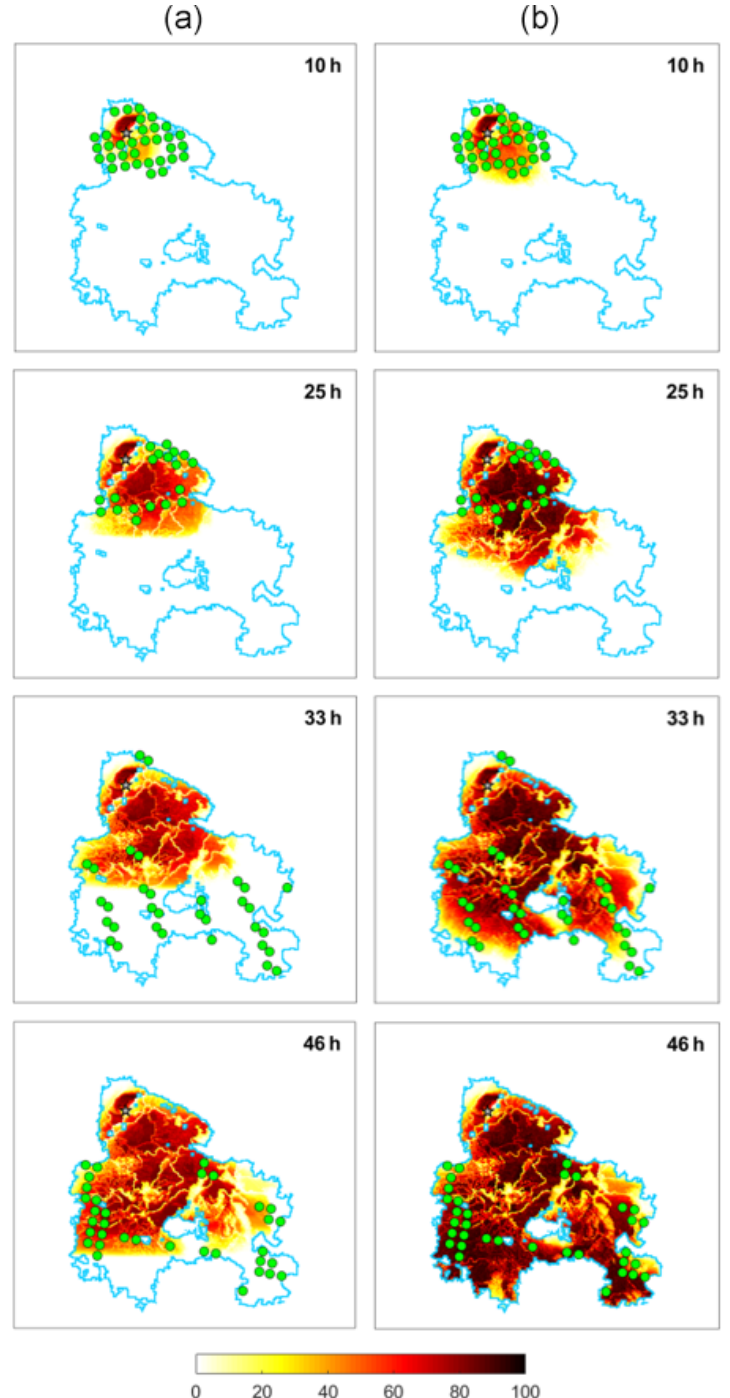
Figure 7. Probabilities of burning (%) for the baseline model (a) and for the modified model (b) . Colors represent the percentage of burned cells as indicated by the color bar in the bottom of the figure and white represents unburned cells. The star locates the fire ignition point, the blue line is the perimeter of the burned area and the green circles represent active fires as detected by MODIS. Both simulations were restricted to the burned